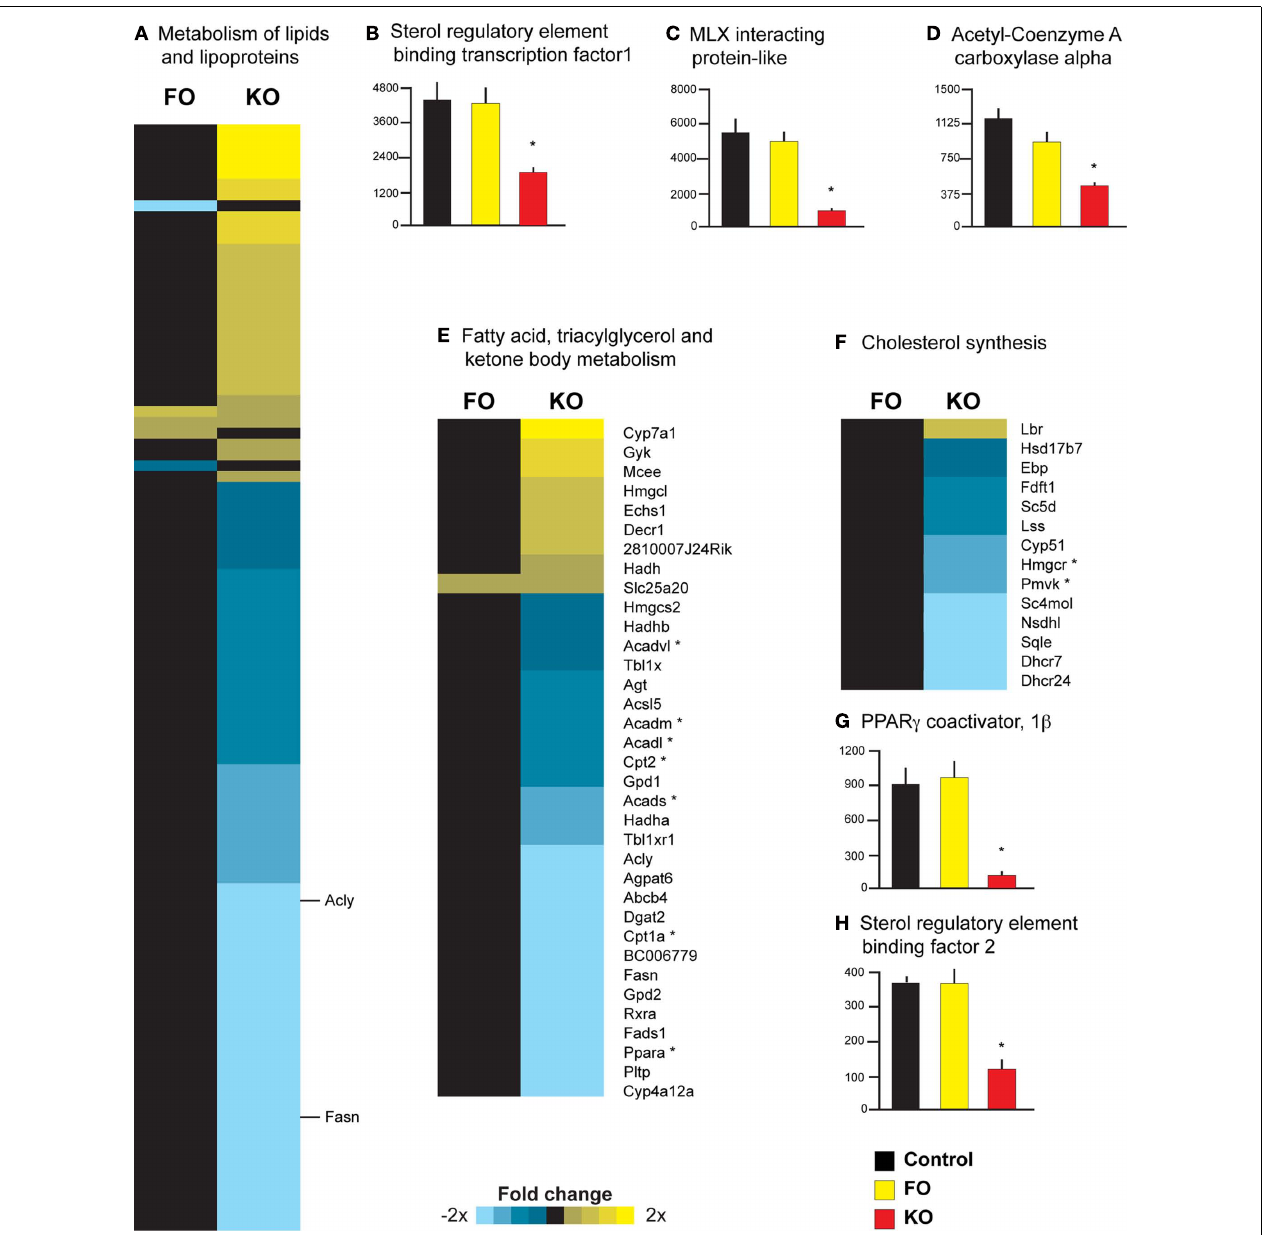
“Fatty acid, triacylglycerol and ketone body metabolism” (E) ; genes highlighted in the Results section are indicated with an asterisk. Pathway analysis also revealed that FO upregulated, whereas KO downregulated, the Reactome pathway “Cholesterol metabolism” (F) .Two regulatory genes in cholesterol synthesis are highlighted in the Results and indicated with an asterisk.Two transcriptional cofactors that are upstream regulators of cholesterol synthesis [ Ppargc1b , (G) and Srebf2 , (H) ] were also decreased in expression only by KO. be the important regulators of cholesterol synthesis in response to dietary fatty acid saturation. Plasma analysis showed no significant changes in triglyceride, total cholesterol, free fatty acids, phospholipids, or insulin levels in either treatment groups ( Table 2